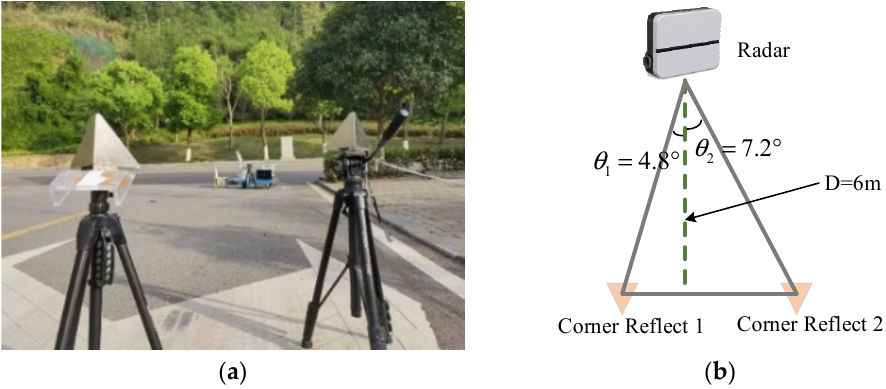
Figure 10. The measured scenario with 77 GHz millimeter-wave array. ( a ) The measured scenario, ( b ) The scenario schematic.